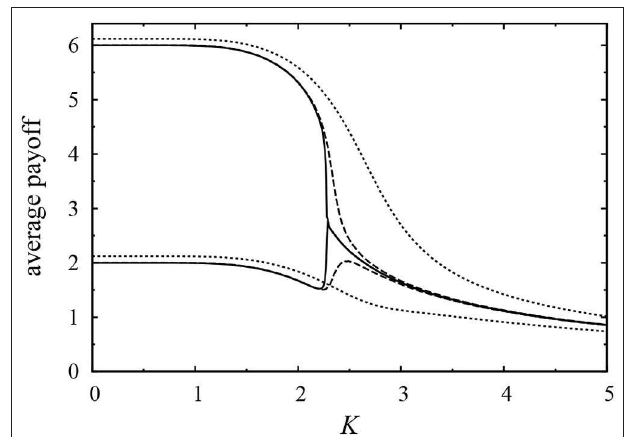
FIGURE 2 | Average payoffs as a function of K in the evolutionary games shown in Figure 1 with additional cross-dependent components 1. γ 2 ( γ 1 0.5 and 0.5, the former leading to higher and the latter leading = = − = − ε 2 0 case. The to lower average payoffs). The solid, dashed, and dotted lines refer to the = = same self-dependent parameter values as in Figure 1 ε 2 ε 2 0.001 and ε 1 0.03. = − = = − =